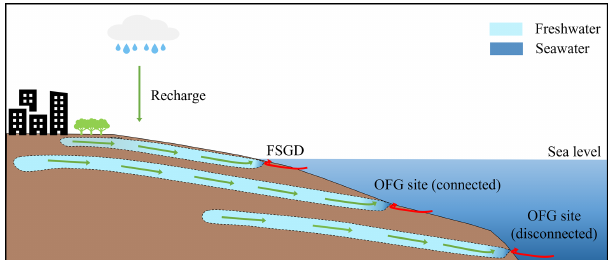
Figure 1. Schematic representation of known pathways for the transport and storage of fresh and freshened groundwater between terrestrial and marine realms. Areas surrounded by dashed lines in- dicate groundwater reservoirs, whereas arrows represent freshwater (green) and seawater (red) fluxes. Based on Bratton et al. (2010) and Weymer et al.